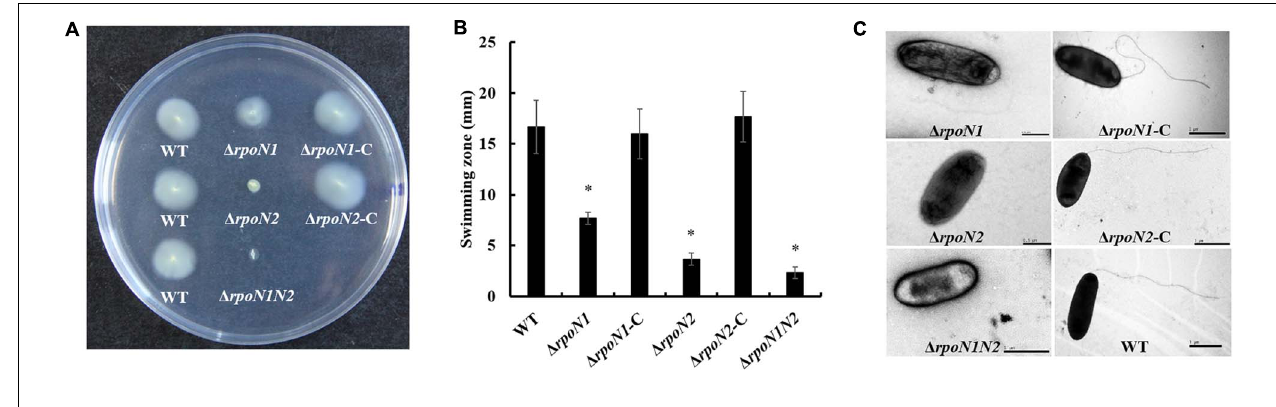
FIGURE 1 | RpoN1 and RpoN2 for swimming motility and flagellar assembly in Xanthomonas oryzae pv. oryzae ( Xoo ). (A) Schematic representation and (B) quantitative analysis of swimming motility assay. The values represent the average of three independent experiments. Asterisks indicate significant differences between wild-type and mutants ( P < 0.05) (Student’s t test). (C) Visualization of flagellar filament using scanning electron microscopy. WT, wild-type; (cid:49) rpoN1 , rpoN1 gene deletion mutant; (cid:49) rpoN1 -C, the complemented strain of (cid:49) rpoN1 ; (cid:49) rpoN2 , rpoN2 gene deletion mutant; (cid:49) rpoN2 -C, the complemented strain of (cid:49) rpoN2 ; (cid:49) rpoN1N2 , double gene ( rpoN1 and rpoN2 ) deletion